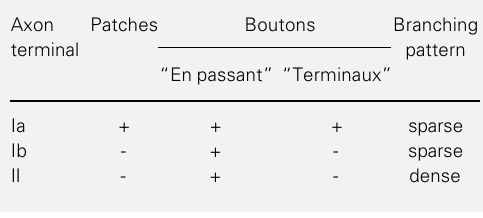
Table 1 - Qualitative analysis of intrinsic axon terminals of V1 of Cebus apella